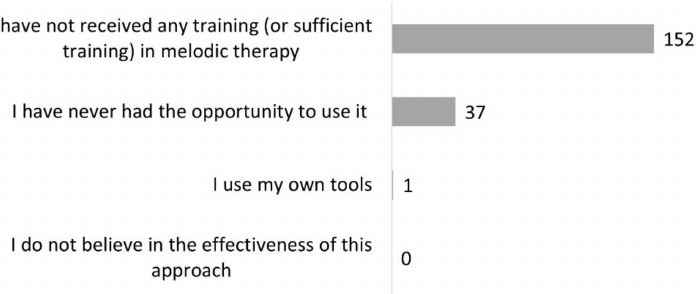
Figure 3. Reasons why participants have never used melodic therapy (question #11 of the question- naire, 175 respondents).